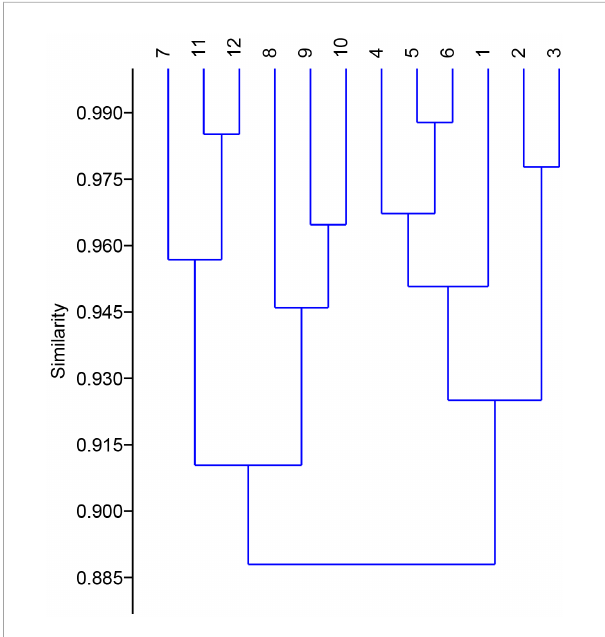
FIGURE 6 Dendrogram based on Paired group (UPGMA) algorithm using similarity index Bray-curtis for clustering of control and treated plants on the basis of growth and physico-chemical parameters. (1. Control plants 2. NCT4 treated plants 3. NCT1 treated plants 4. LCT4 treated plants 5. LAT3 treated plants 6. LBM4 treated plants 7. Control plants grown in presence of salt 8. NCT4+salt treated plants 9. NCT1+salt treated plants 10. LCT4+salt treated plants 11. LAT3+salt treated plants 12. LBM4+salt treated